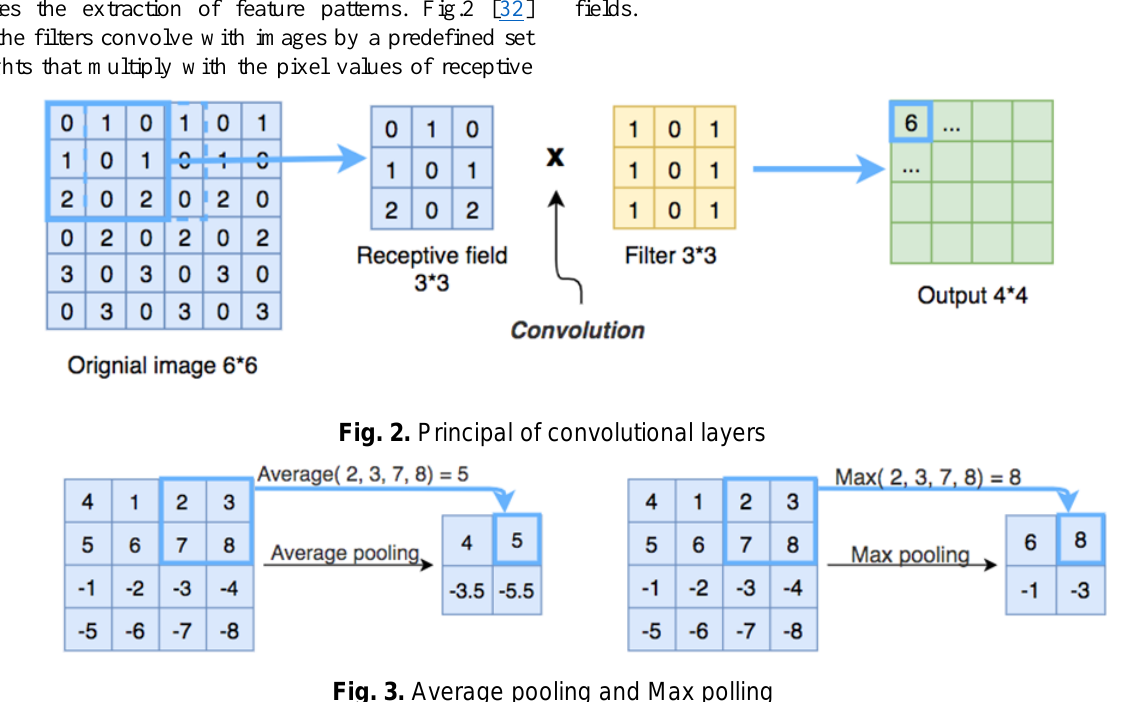
Fig. 3. Average pooling and Max polling